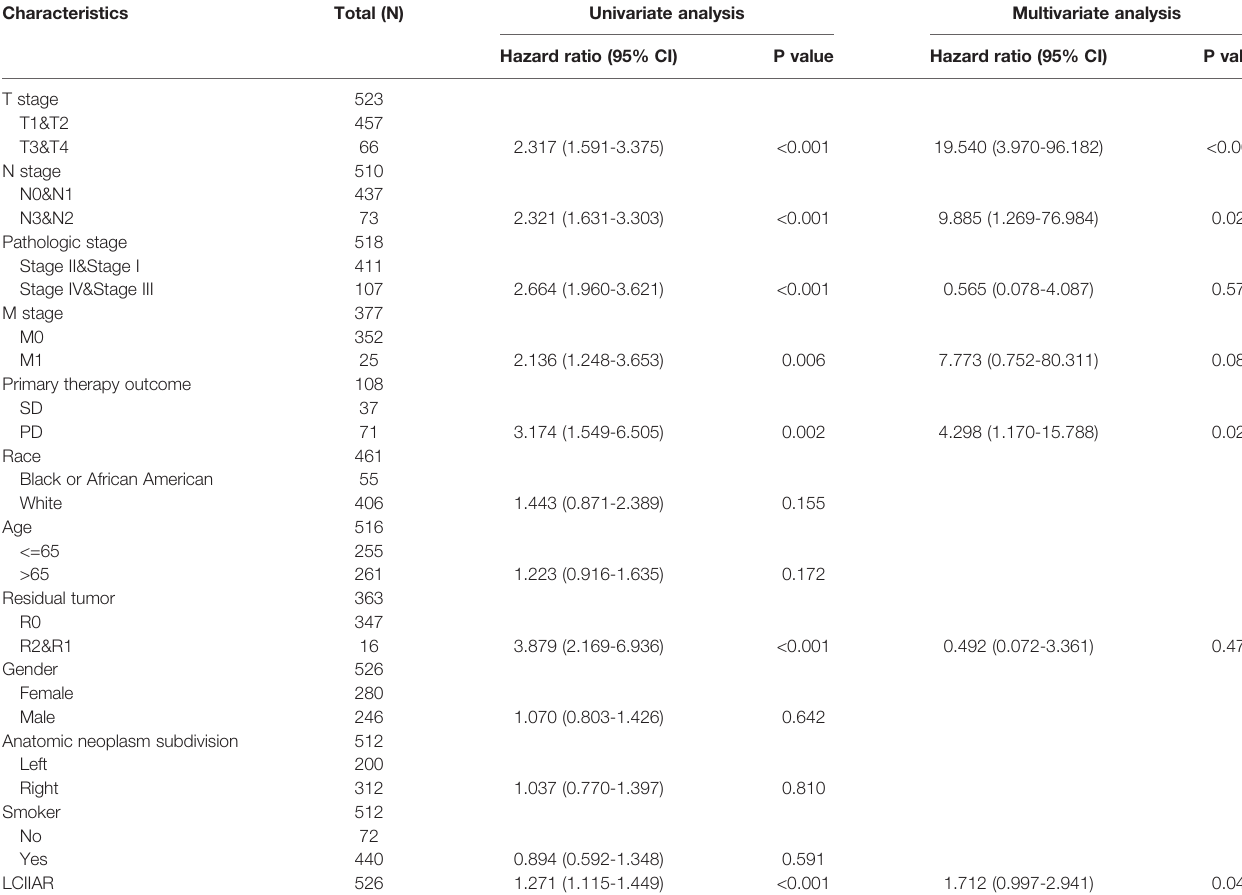
TABLE 2 | Univariate regression and multivariate survival model of prognostic covariates in patients with lung cancer.